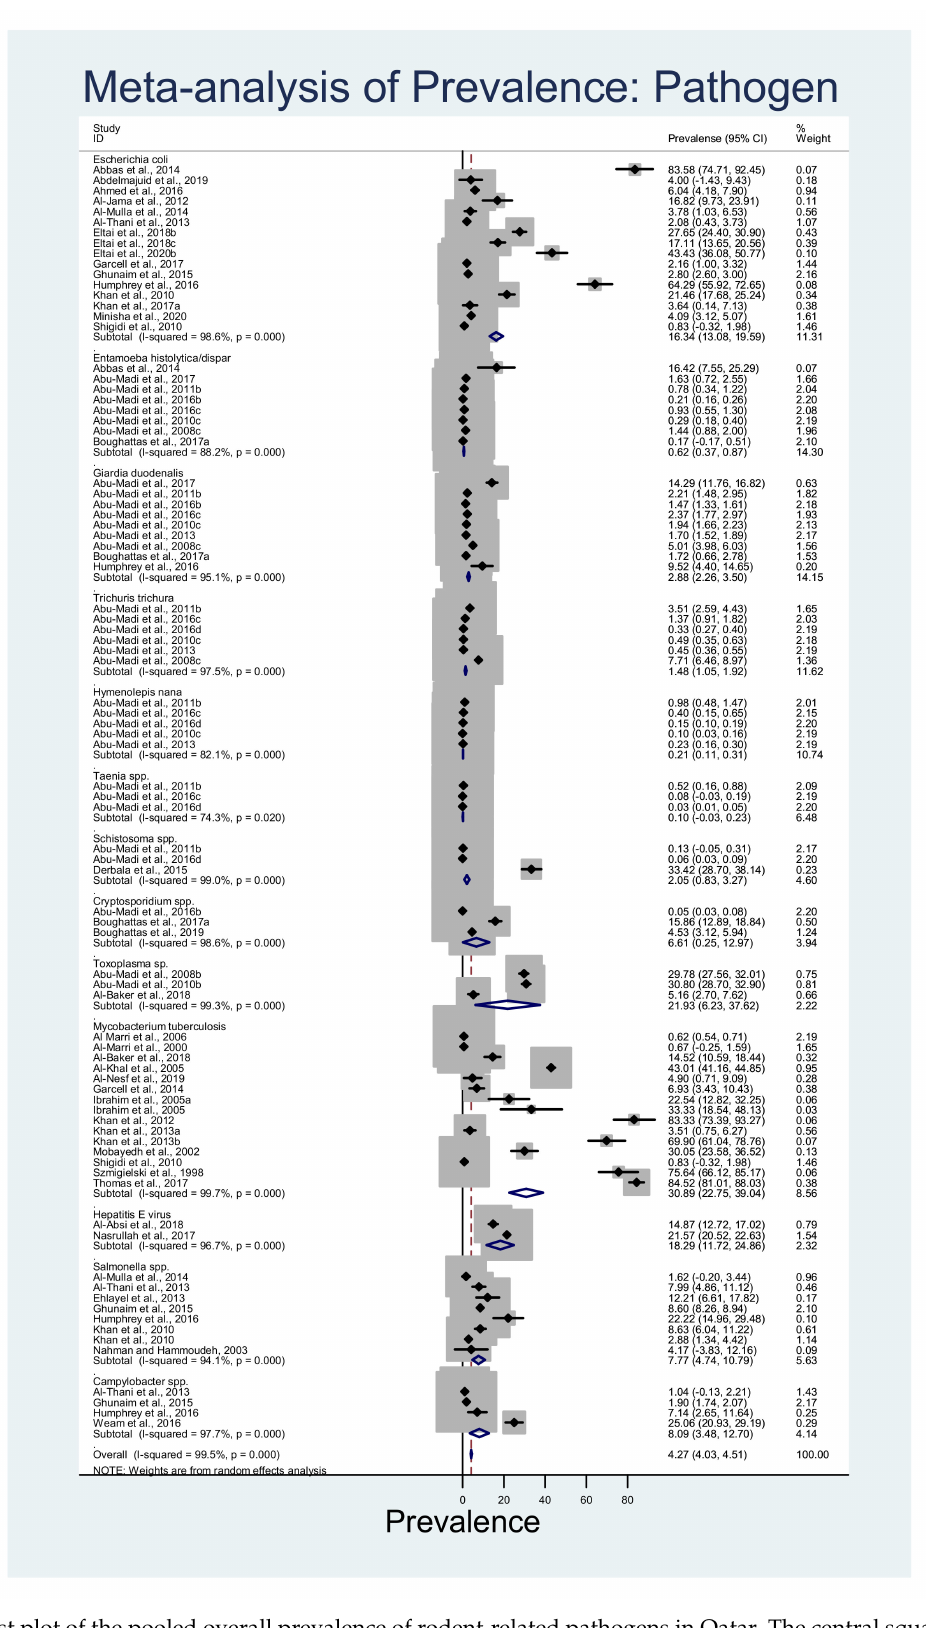
Figure 3. Forest plot of the pooled overall prevalence of rodent-related pathogens in Qatar. The central square represents point estimates, whereas the square size represents the weight of each study in the